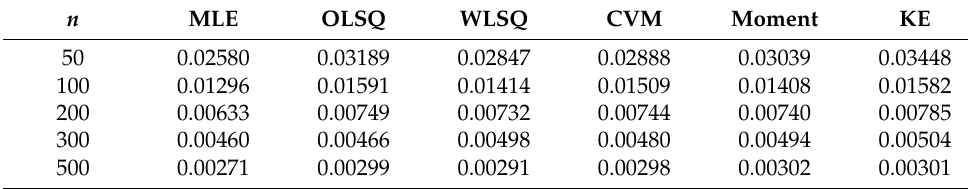
Table 3. Simulation results for δ =